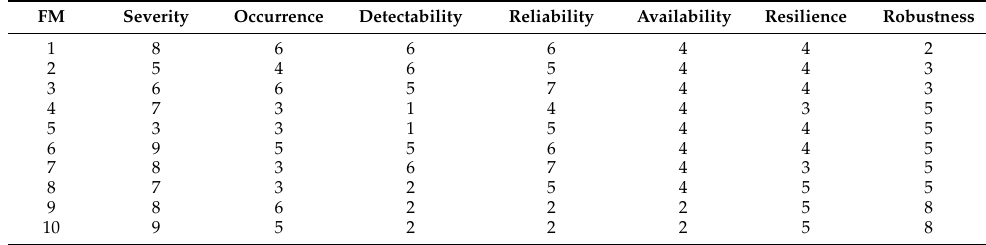
Table 4. Inlet corrosion repair project—risk and performance ratings using a 10-point scale.